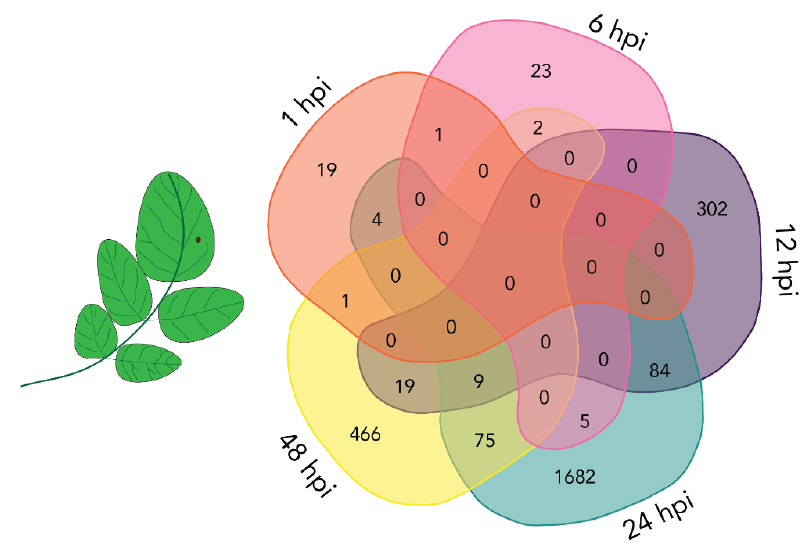
Figure 3. Venn diagram displaying overlap between differentially expressed transcripts (DETs) from potato detected at different time points after inoculation (hours post inoculation, hpi). Comparison between DETs at 1 hpi (orange), 6 hpi (pink), 12 hpi (purple), 24 hpi (green) and 48 hpi (yellow). Numbers represent unique or overlapping DETs between time points.